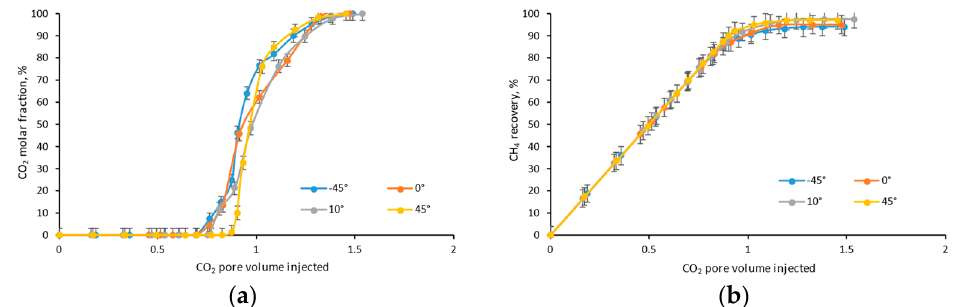
Figure 13. The variation curves under different dip angles. ( a ) CO 2 content at the long core outlet; ( b ) CH 4 recovery.